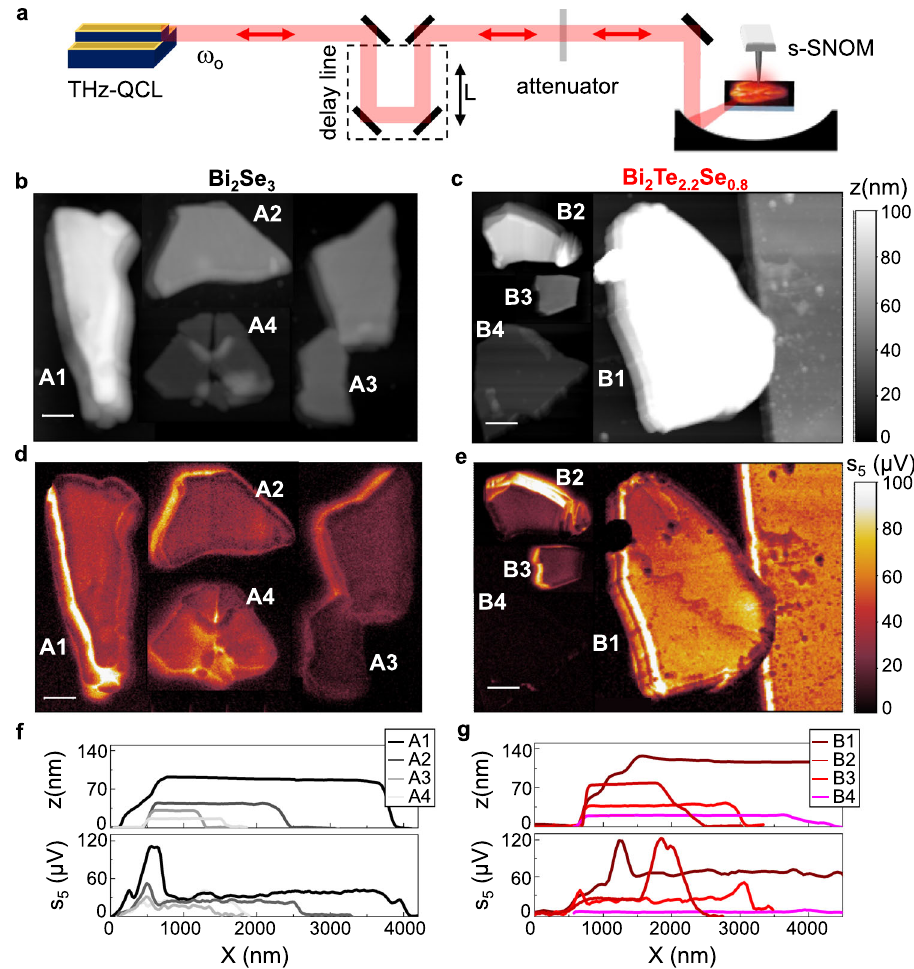
Fig. 2 Self-detection THz nanoscopy of TIs. a Sketch of the self-detection nanoscopy experiment based on THz-QCL of frequency ω 0 = 66.7, 76.7, 89.7 cm − 1 simultaneously serving as source and detector of the backscattered fi eld from the AFM tip of the s-SNOM with a delay-line controlling the length L of the optical path and an attenuator to reduce the feedback intensity. b , c Topography maps of four distinctive fl akes of Bi 2 Se 3 ( a ) and Bi 2 Te 2.2 Se 0.8 ( b ) of variable thickness z with labels Ai and Bi, respectively, with i = 1, 2, 3, 4. d , e Near- fi eld maps of the fi fth-order self-mixing signal s 5 of the fl akes in panels ( b , c ) taken while keeping a fi xed external cavity length L, measured with ω 0 = 66.7 cm − 1 without attenuation. Scale bars in panels ( b – e ) correspond to 1 μ m. f , g Line scans of the topography maps z and of the fi fth-order self-mixing signal s 5 on four distinctive fl akes of Bi 2 Se 3 ( f ) and of Bi 2 Te 2.2 Se 0.8 ( g ), extracted from panels ( b , c ) and ( d , e ) while moving from the substrate to the fl akes along a line orthogonal to the fl akes